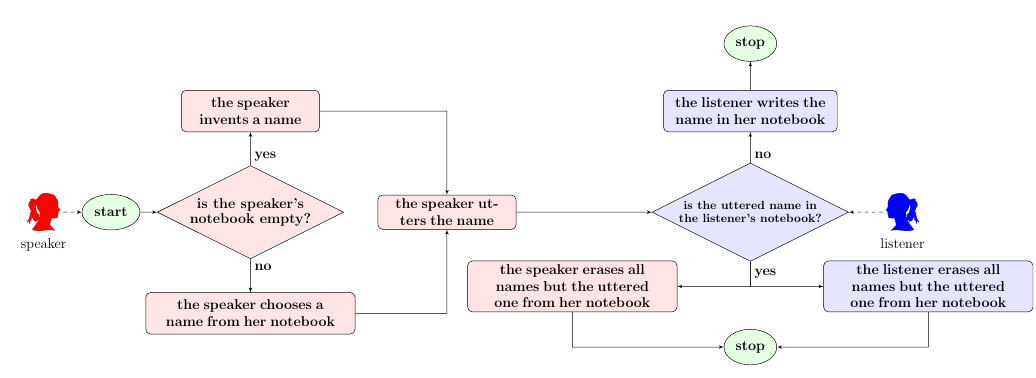
Figure 1. Speaker-listener